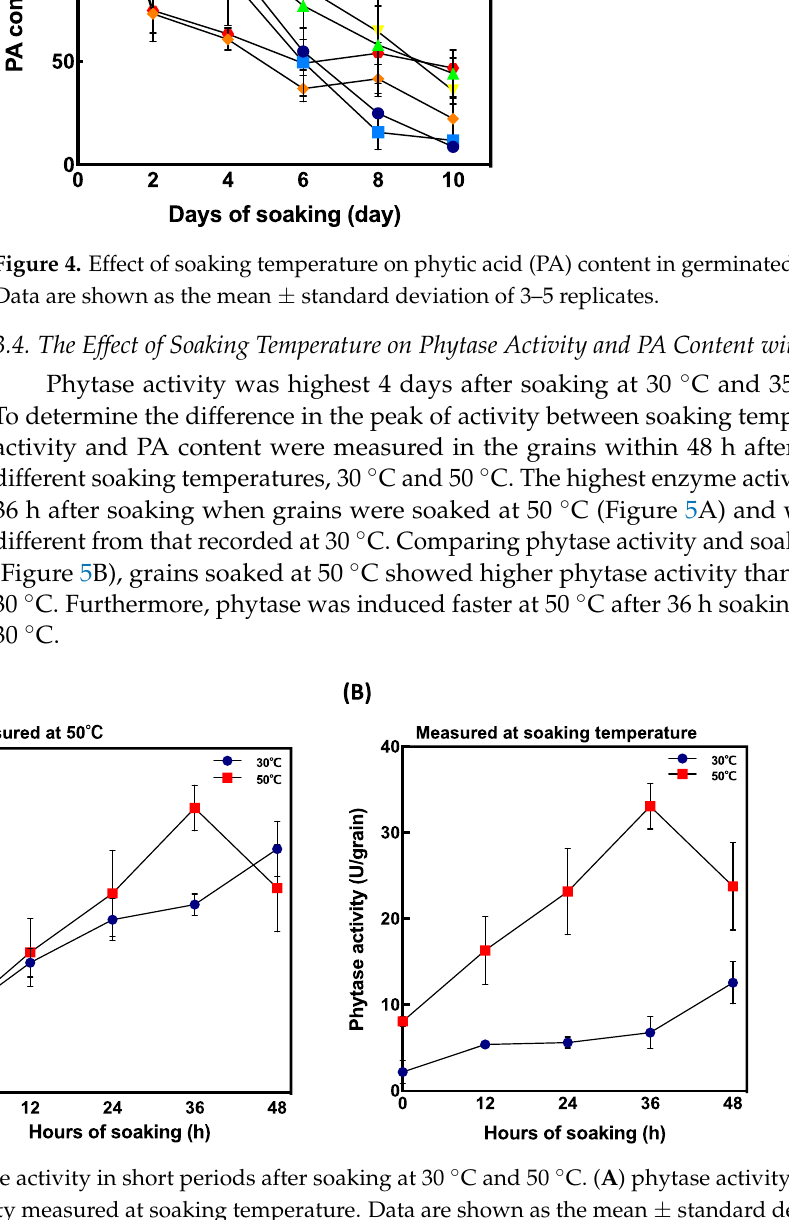
Figure 3. Effect of soaking temperature on phytase activity in germinated brown rice (GBR). ( A ) phytase activity measured at 50 °C and ( B ) phytase activity measured at soaking temperature. Data are shown as the mean ± standard deviation from 3–5 replicates.